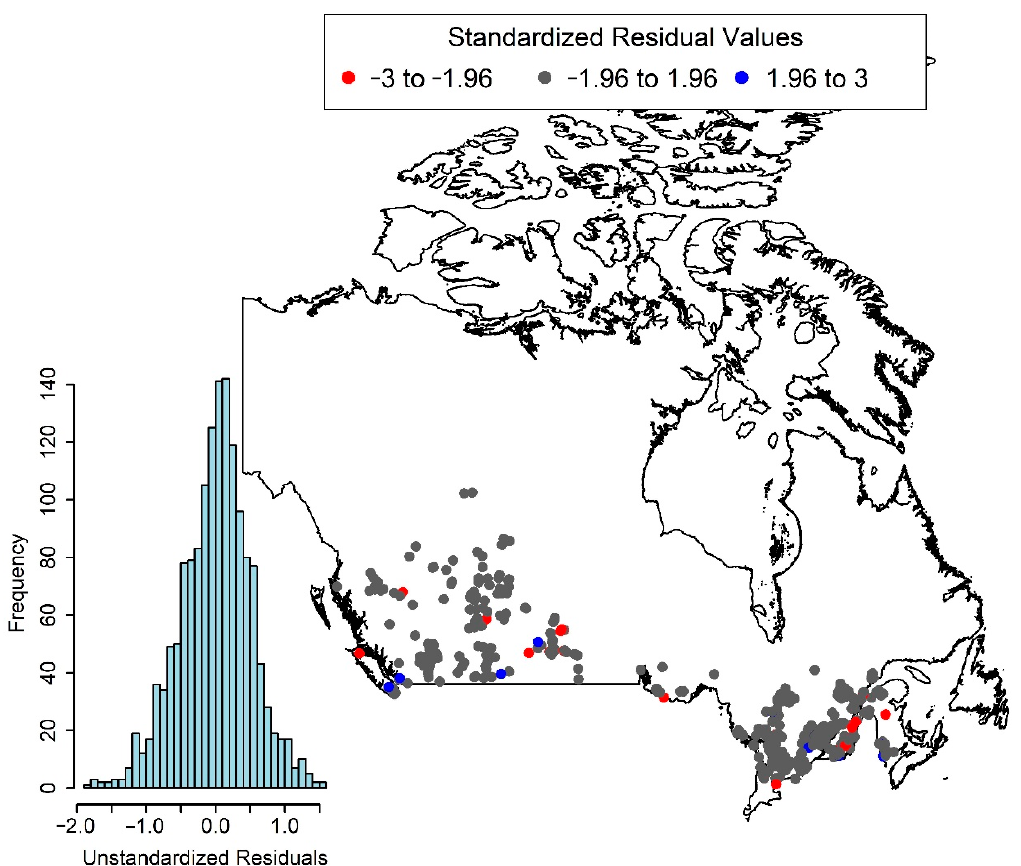
Figure 6. Standardized (on map) and unstandardized residuals (on histogram) for global regression model between in situ SDD and Landsat 8 Blue/Red for data taken within a one-week temporal window of each other. Table 3. Expanded regression models estimating in situ SDD from Landsat 8 Blue/Red surface reflectance using additional terms or different order polynomial models. Models use data for the seven-day temporal window between date of in situ sample and date of satellite overpass. (df = degree of freedom; RMSE = root mean square